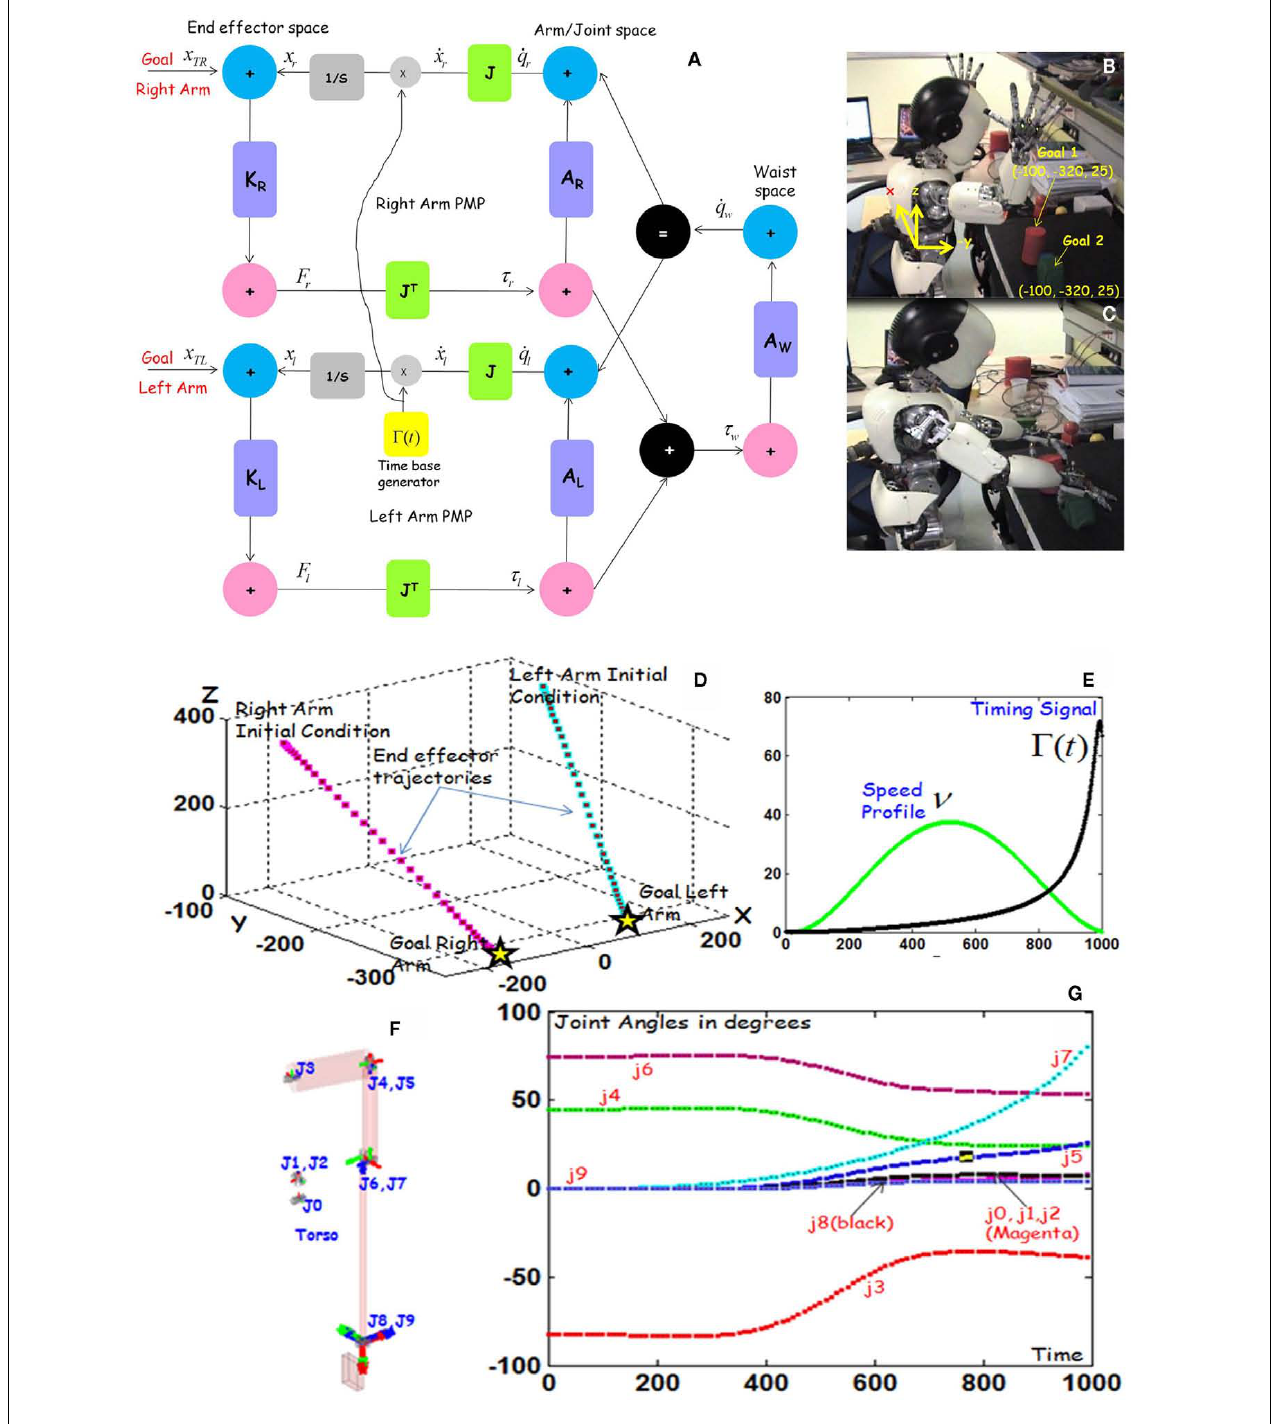
the initial and the final posture of the robot and the two target objects. (D,E) Show the trajectories of the two end-effectors and the corresponding speed profiles (together with the output Γ (t) of the time base generator). (F) Clarifies the intrinsic degrees of freedom in the right arm-torso chain. (G) Shows the time course of the right-arm joint rotation patterns: J 0– J 2: joint angles of theWaist (yaw, roll, pitch); J 3– J 9: joint angles of the Right Arm (shoulder pitch/yaw/roll; elbow flexion/extension; wrist prono supination